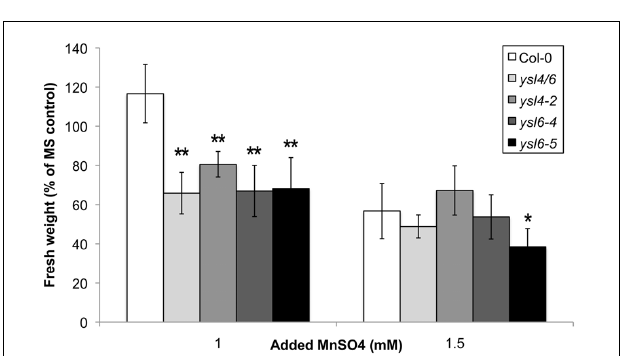
FIGURE 11 | Manganese sensitivity of ysl mutants. Seeds of Col-0, ysl4ysl6 double mutants, ysl4-2 , ysl6-4 and ysl6-5 single mutants were sown onto MS medium containing either 0, 1.0 or 1.5mM excess MnSO4 and grown for 21 days. Fresh weights were measured by weighing batches of 5 seedlings each. Weights are expressed as a percentage of the weights of seedlings grown under the control condition (MS medium without excess MnSO4). n = 3–5 batches of seedlings. ∗ p ≤ 0 . 05 and > 0 . 01, ∗∗ p ≤ 0 . 01.